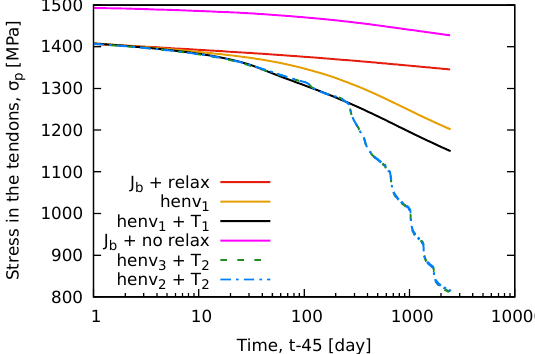
Figure 5. Decrease in prestress in horizontal tendons due to steel relaxation, concrete creep and shrinkage.